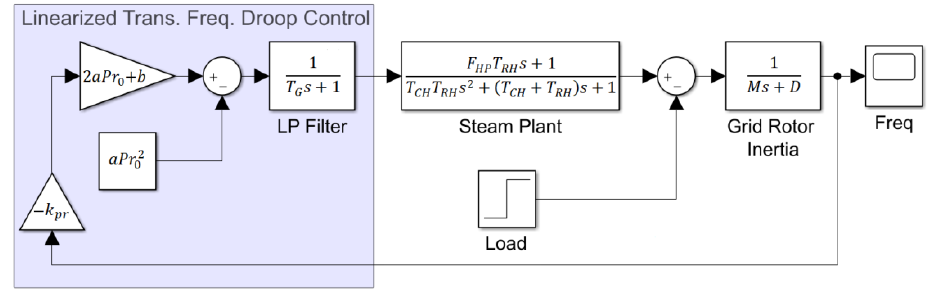
Figure 3. Transactive frequency droop control diagram.